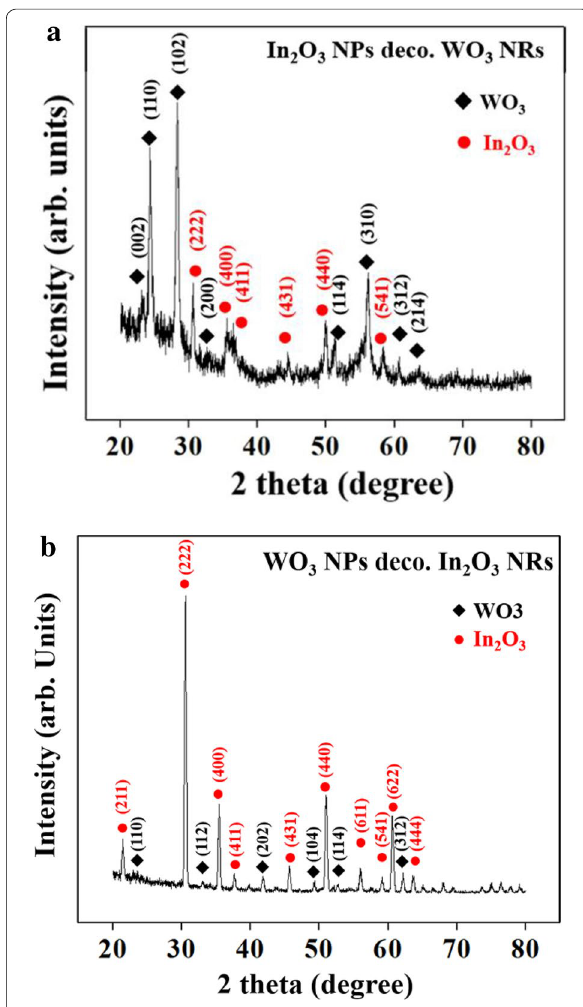
Fig. 2 XRD patterns of a In 2 O 3 NPs‑decorated WO 3 NRs and b WO 3 NPs‑decorated In 2 O 3